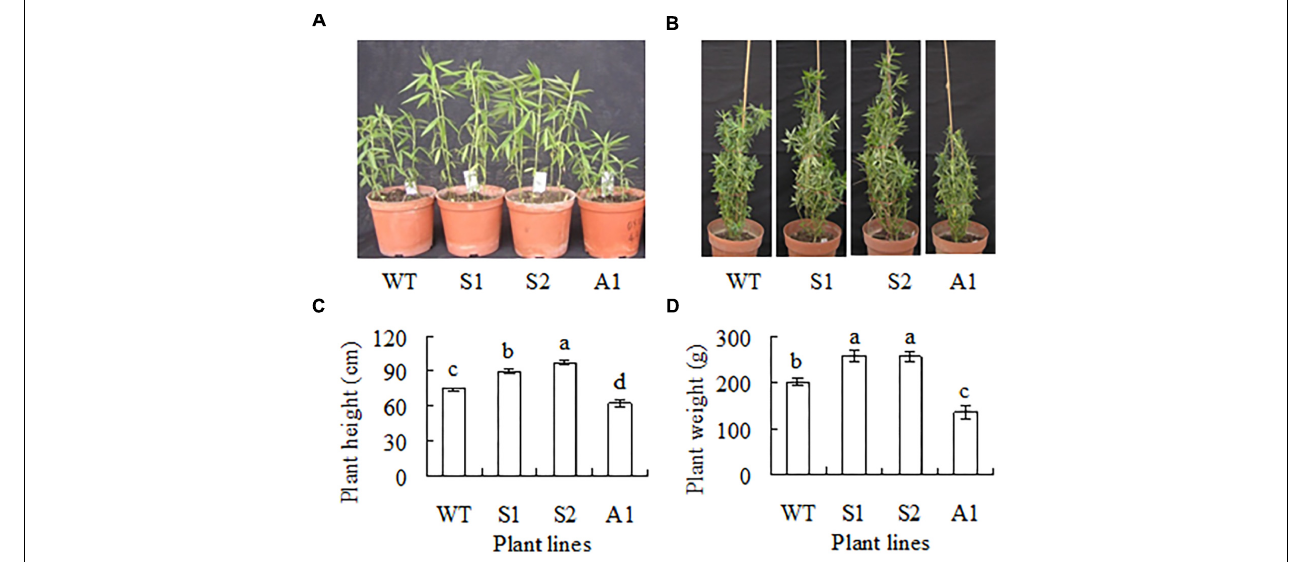
FIGURE 4 | Phenotype of transgenic plants overexpressing SgCP12 or down-regulating SgCP12 expression in comparison with the wild type ( S . guianensis cv. CIAT184). The photos show five-week-old (A) and 12-week-old plants (B) . Plant height (C) and fresh weight per plant above ground (D) were measured 12 weeks after planting. Means of data from ten plants and standard errors are presented; the same letter above the column indicates no significant difference among the tested plant lines at P < 0.05.